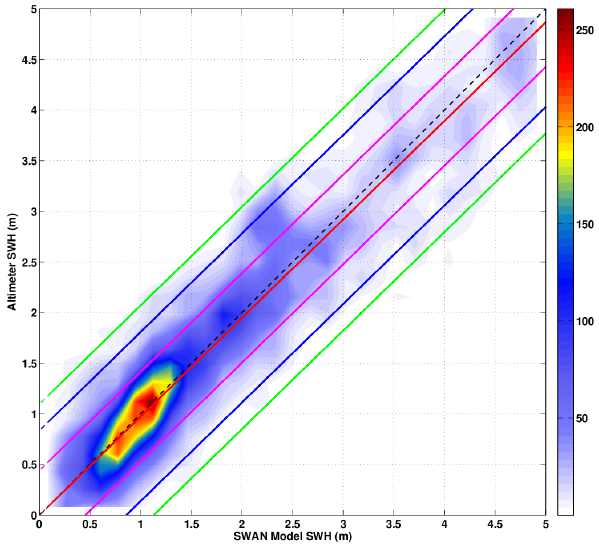
Figure 3. Colour scale representing the density of significant wave height (SWH) points for the whole Mediterranean basin. The axes represent the altimeter wave height (vertical axis) vs. the SWAN wave height (horizontal axis), both in metres. The red line corre- sponds to a linear fitting, the magenta, blue and green lines indicat- ing the confidence intervals of 70, 95 and 99%